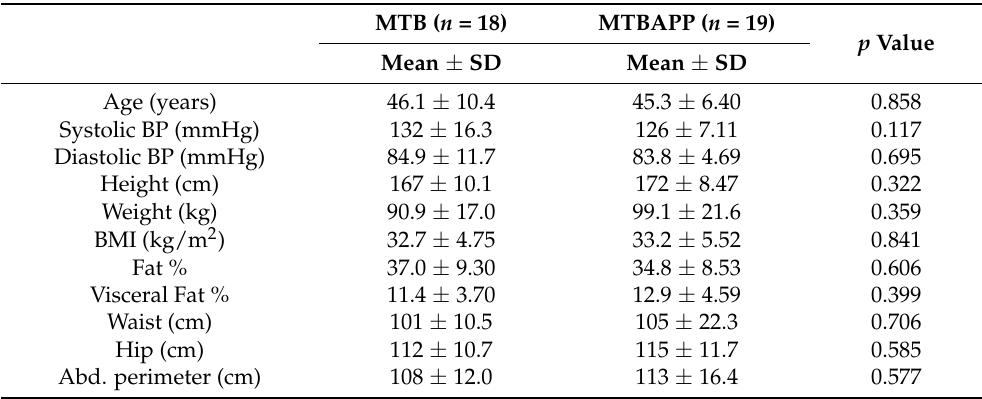
Table 1. Demographics of MTB and MTBAPP